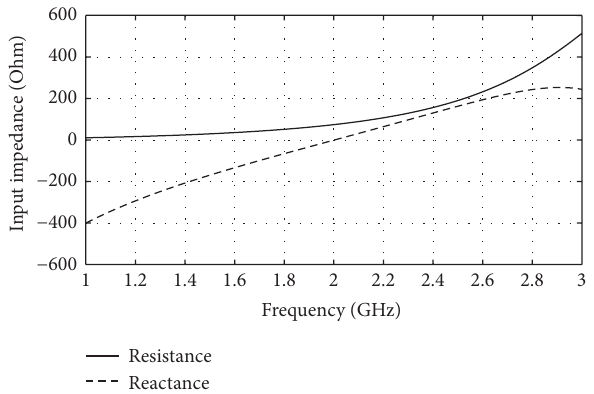
Figure 14: Variation of the strip-dipole antenna impedance with the frequency; dipole dimensions: 𝐿 𝐷 = 7.2 cm and 𝑊 𝐷 = 2.2 mm.